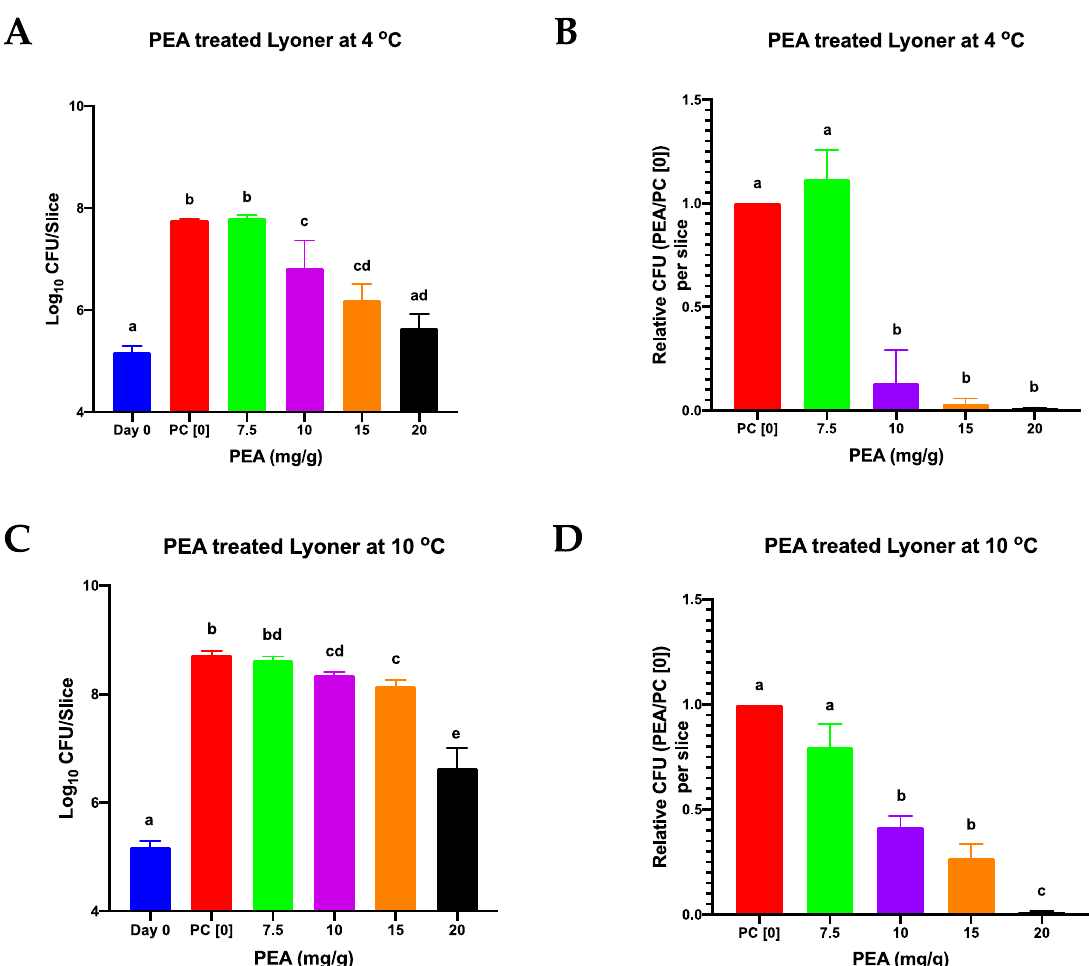
Figure 3. E ff ect of PEA on bacterial counts on lyoner sausage treated with di ff erent PEA concentrations and contaminated with a cocktail of four L. monocytogenes strains and stored for 11 and 7 days at 4 ◦ C ( A , B ) or 10 ◦ C ( C , D ), respectively. ( A , C ): Viable bacterial counts were determined and expressed in Log CFU per slice. ( B , D ): CFU levels determined per PEA lyoner slice expressed relative to those of the positive control with no PEA added (PC [0]) slices. PC [0] denotes the positive control sample (PEA untreated, L. monocytogenes inoculated slices). Data shown are the mean (bars) and standard deviation of three biological replicates. Di ff erent letters indicate significant di ff erences between treatments that were identified through one-way ANOVA and Tukey post-hoc test pairwise comparison of all the treatment conditions ( p < 0.05).